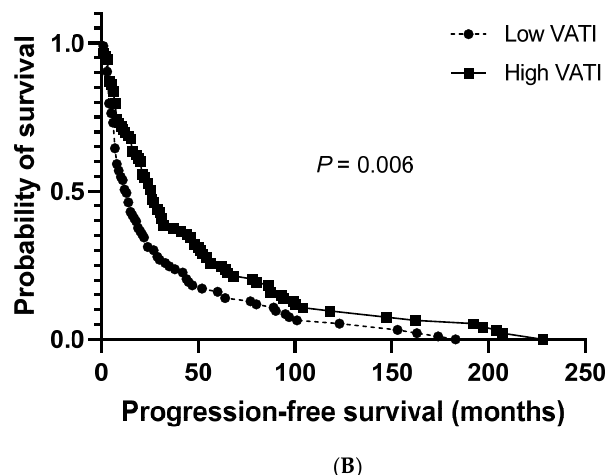
Figure 2. Overall survival. ( A ) Cancer-specific survival in patients with high/low visceral adipose tissue index (VATI). ( B ) Progression-free survival in patients with high/low VATI.